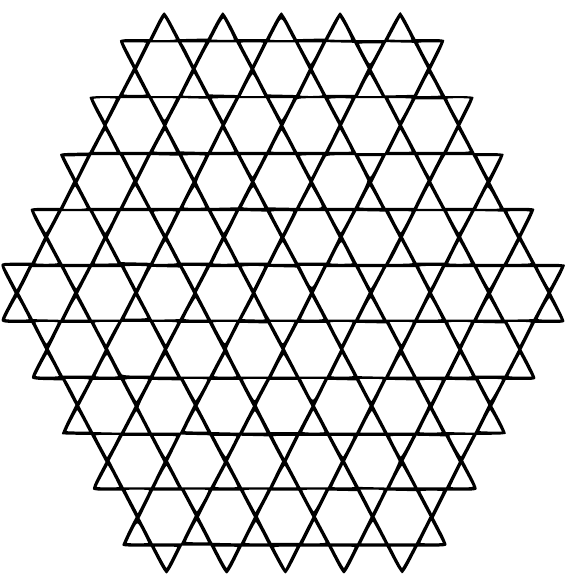
Figure 1: Figure of ( OX 5 )